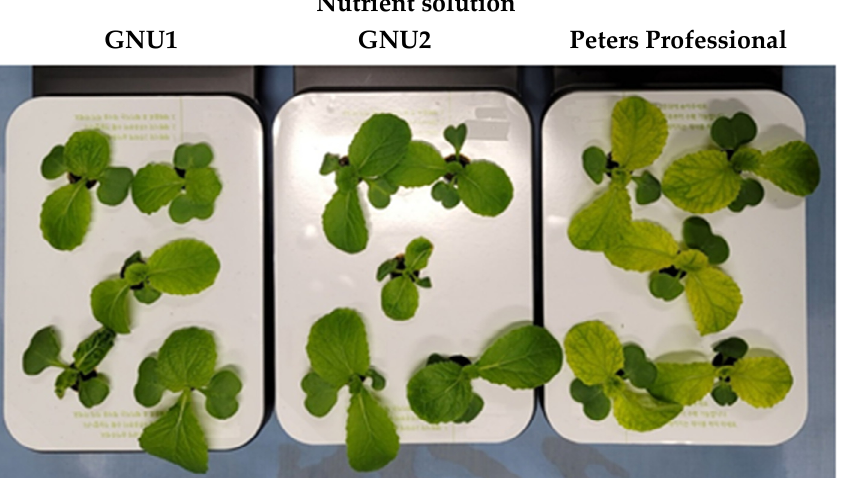
Figure 1. Growth of Ssamchoo as affected by the nutrient solution 7 days after sowing. Peters Professional, GNU1, and GNU2 were the nutrient solutions used in the experiment. Peters Professional is a commercial nutrient solution.